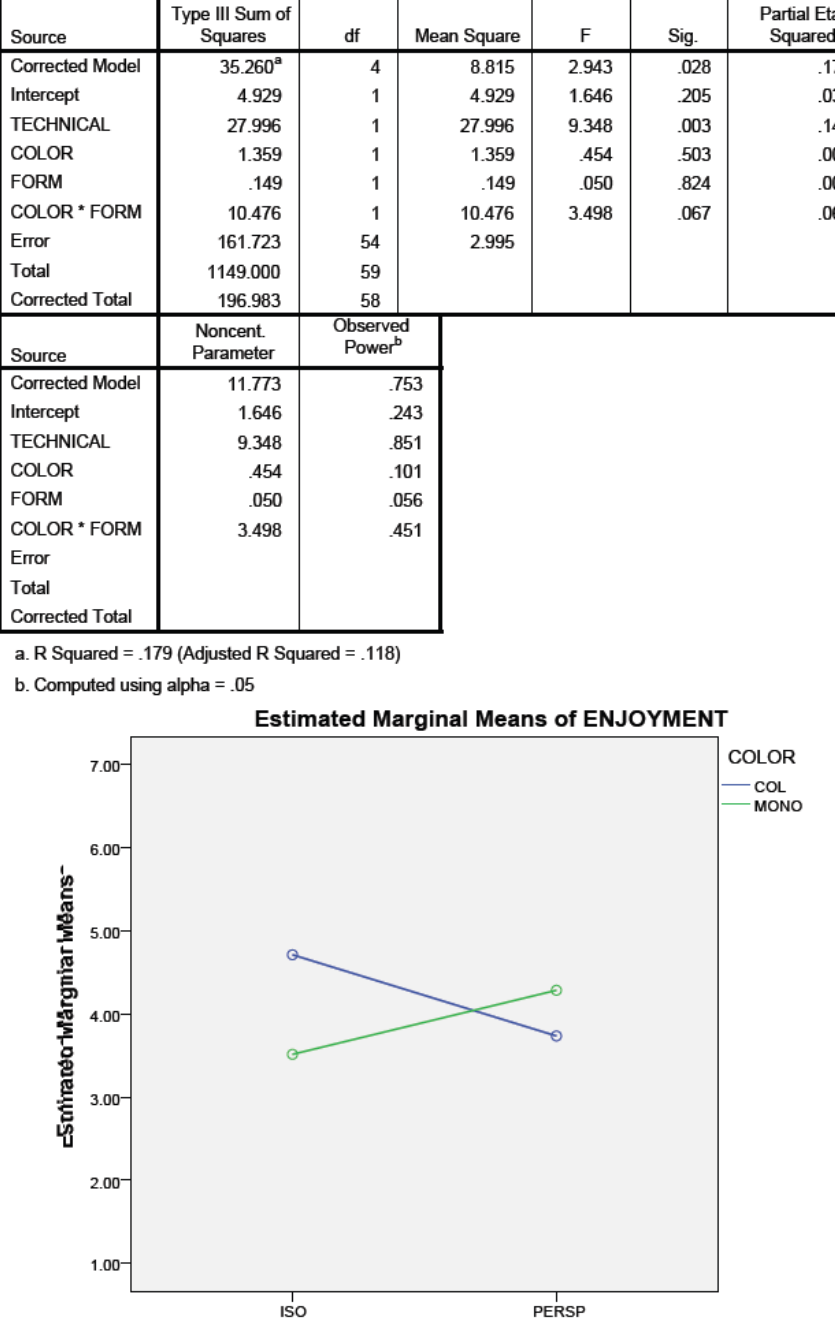
Figure B.20. ANCOVA analysing enjoyment levels for the main and interaction effects of color and form using data adjusted for technical performance for participants who correctly indicated their